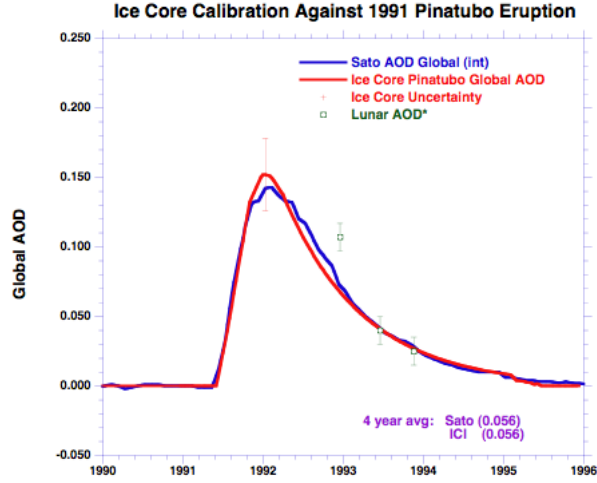
Figure 3. Calibration of ice core “Pinatubo” plume against Sato et al. (1993) global AOD, using rules discussed in the text. Also shown are lunar AOD estimates from Keen